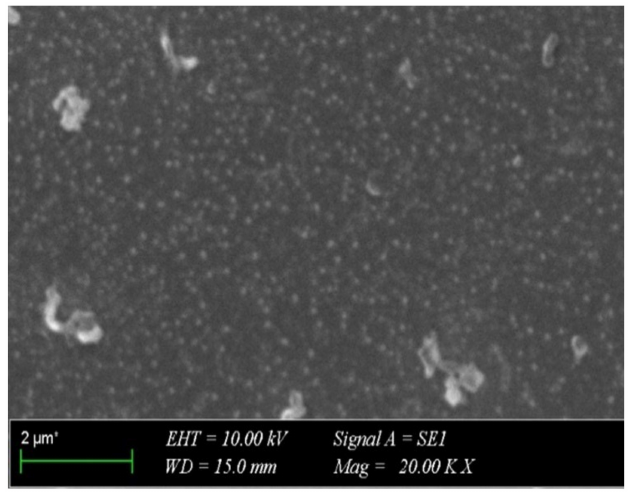
Figure 3. SEM image of the